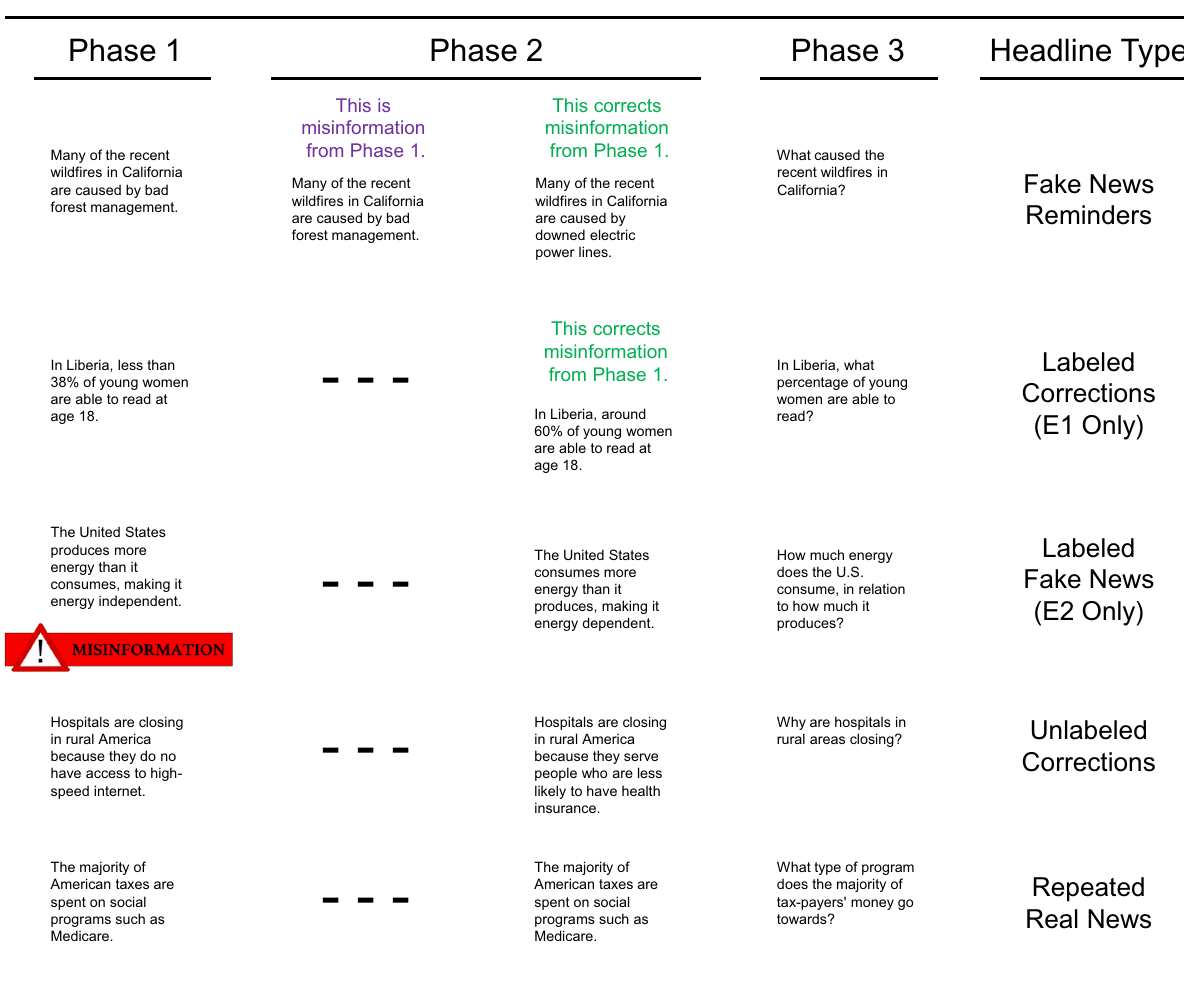
Figure 1. Illustration of the experimental designs. Phase 1 included real and fake news headlines, most of unclear veracity. Phase 2 included corrections of fake news and exact repetitions of real news headlines with the same picture and wording as in Phase 1. The labeled corrections (second row) only appeared in Experiment 1 (E1), and the labeled fake news (third row) only appeared in Experiment 2 (E2). Phase 3 included images that appeared with the headlines from the prior phases and questions about key details that were corrected when headlines appeared as fake news in Phase 1 and corrections in Phase 2. Images that appeared in the experiments are not displayed here due to copyright